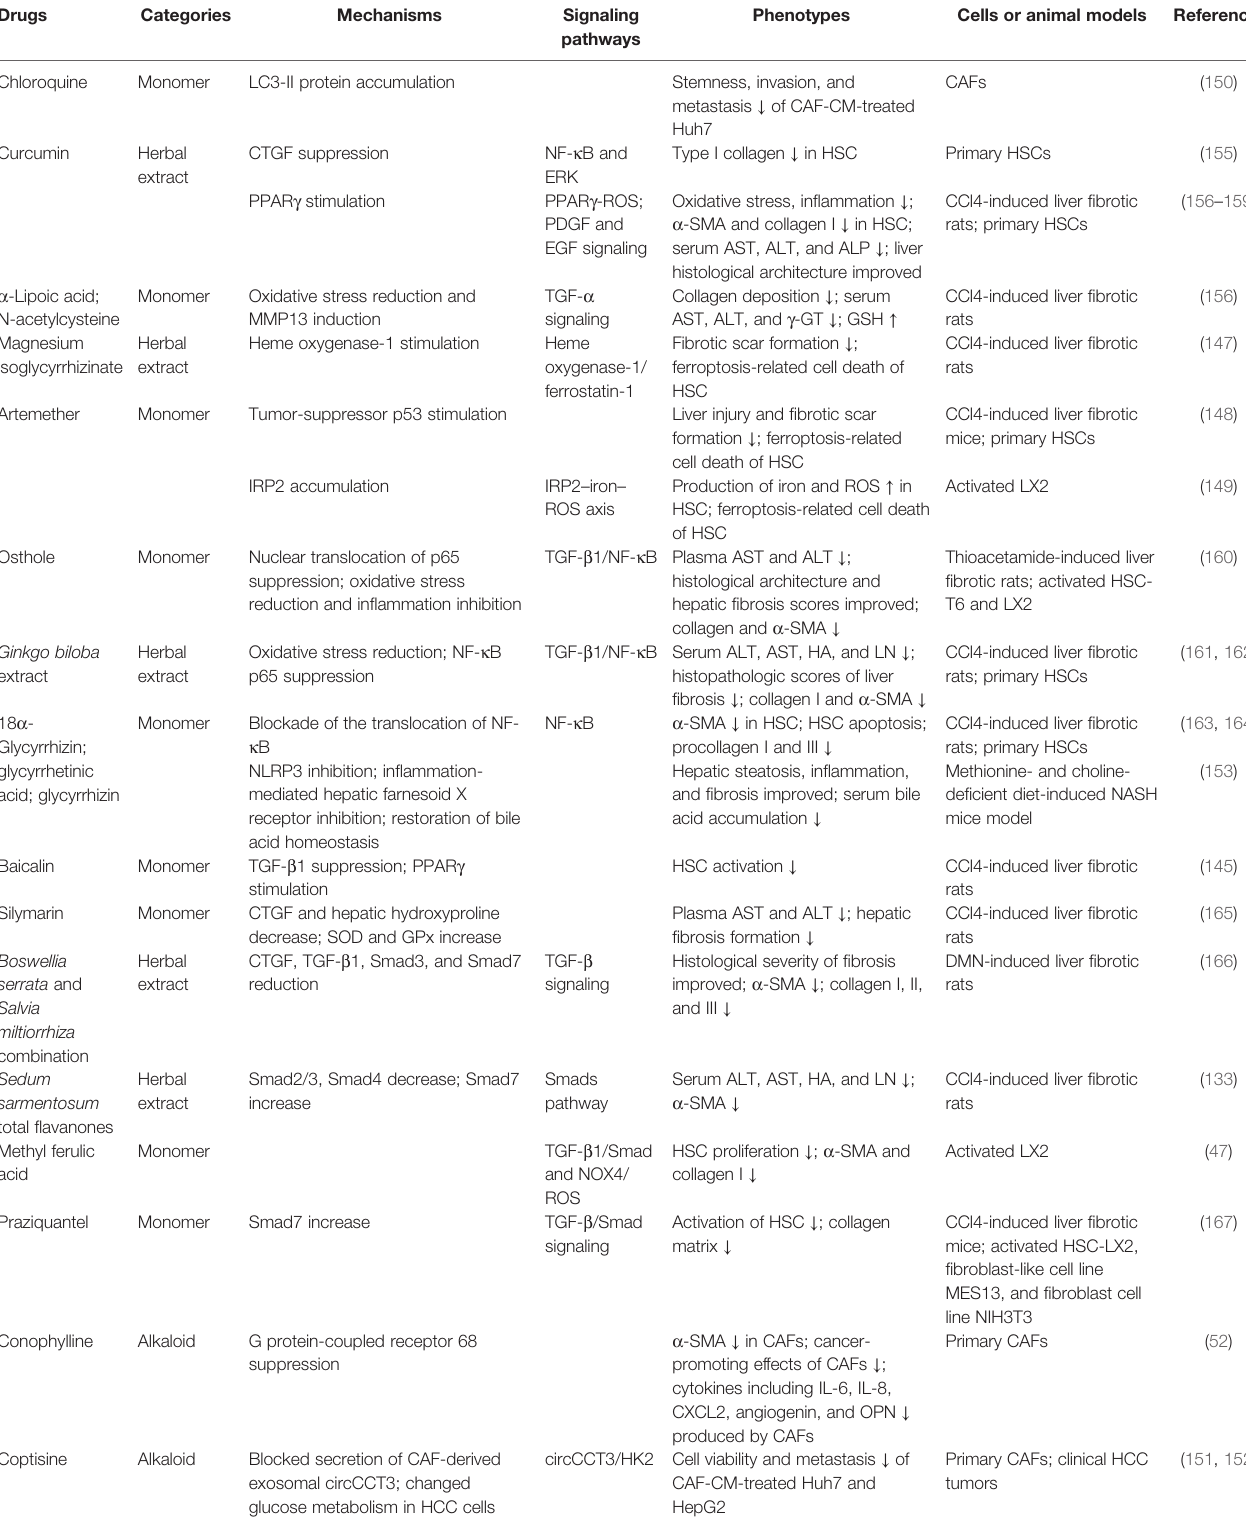
TABLE 2 | Chinese medicine and their derivatives equipped with anti fi brotic